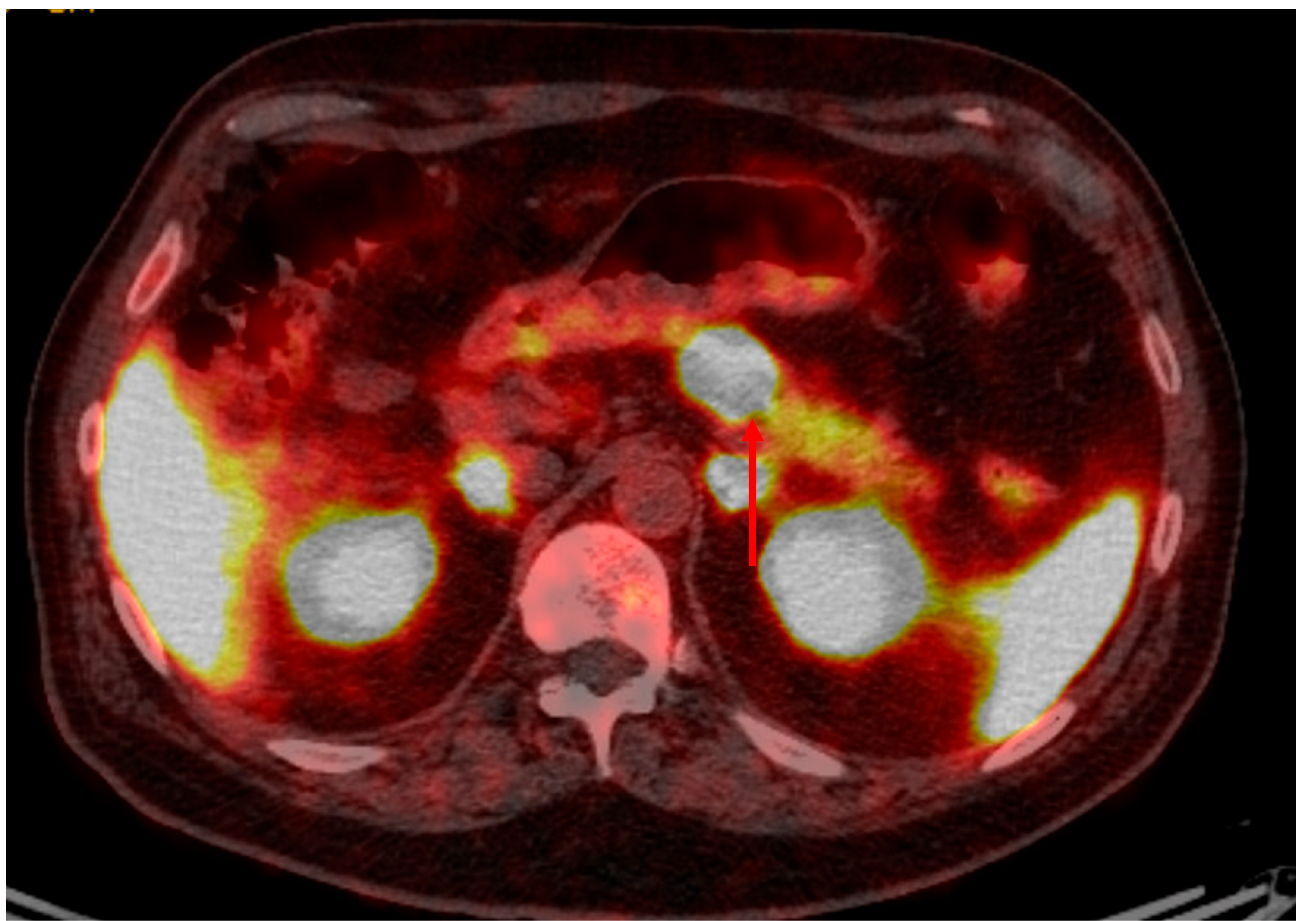
Figure 2. Gallium-68 Dotatate PET/CT (of the patient featured in Figure 1) demonstrating intense dotatate uptake in the pancreatic lesion and expected background activity, consistent with a soma- tostatin receptor positive/dotatate-avid neuroendocrine tumor .